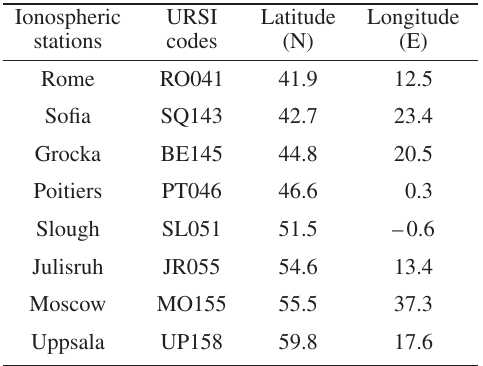
Table I. List of European ionospheric stations with their URSI codes and geographical coordinates.